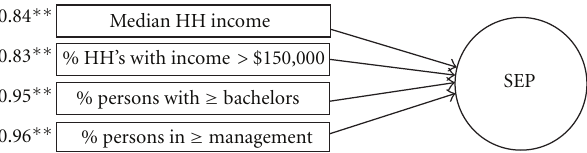
Figure 1: SEP factor structure model. Standardized loadings (ß) to the left of each indicator; ∗∗ p < 0.001; HH =